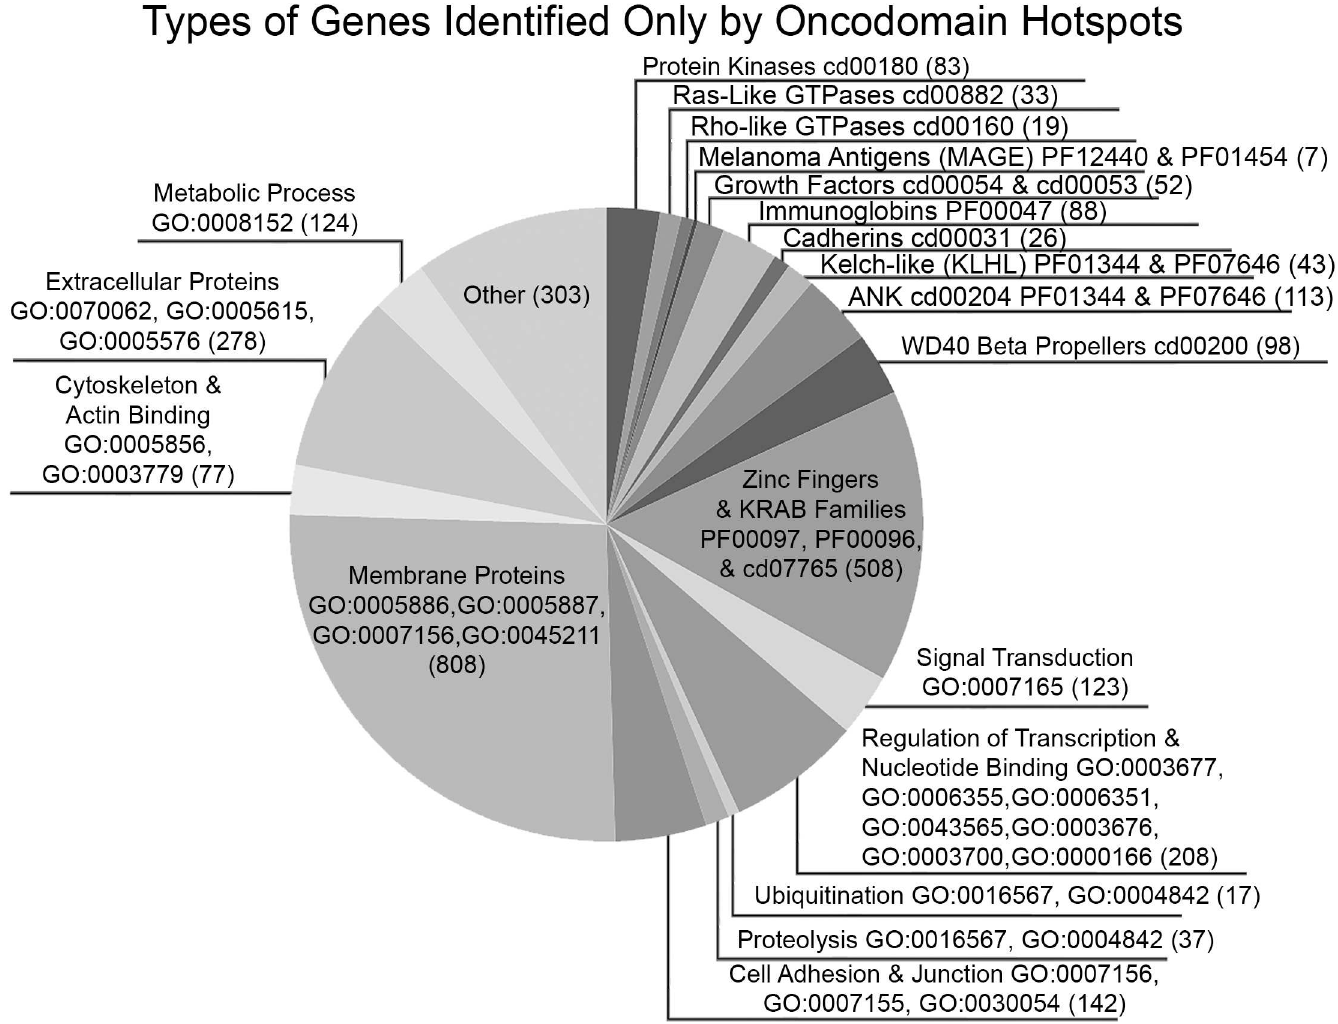
Fig 5. Types of genes identified only by oncodomain